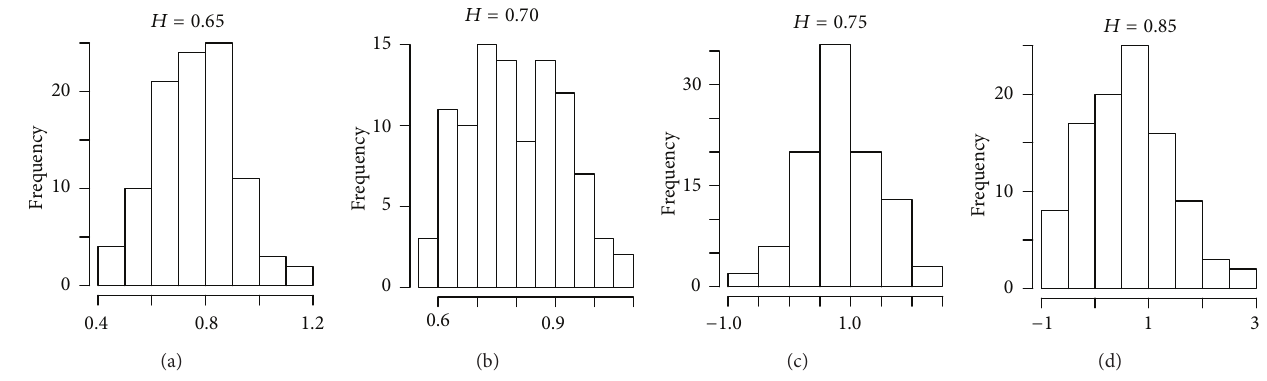
Figure 1: Histogram of the estimator ̂𝛼 ( 𝛼 = 0.7880 ) for different values of 𝐻 .